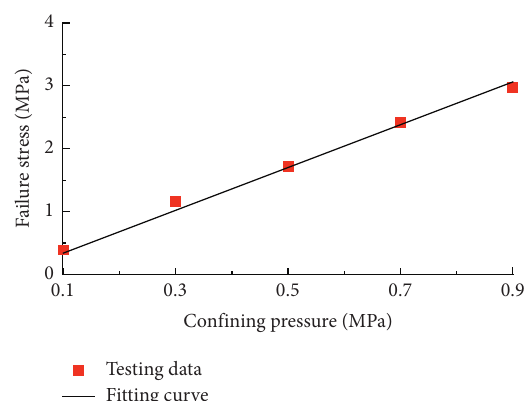
Figure 5: The relationship between confining pressure and failure stress (compaction degree � 100; water content � 8.5%).